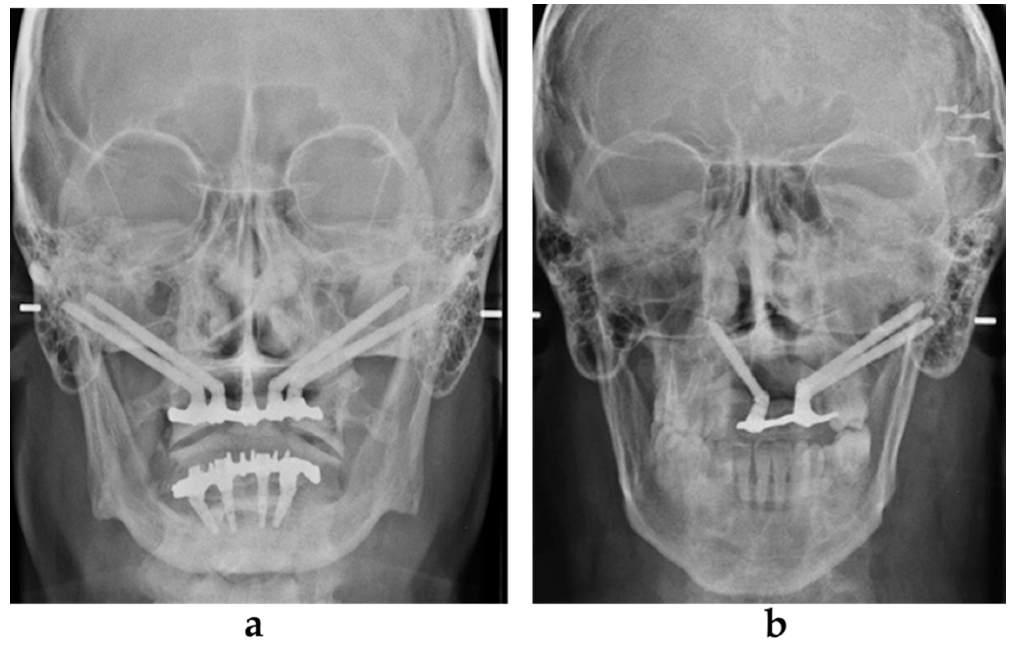
Figure 3. Post-loading radiographic evaluation in a patient with maxillary atrophy ( a ) and in an oncologic patient ( b ).